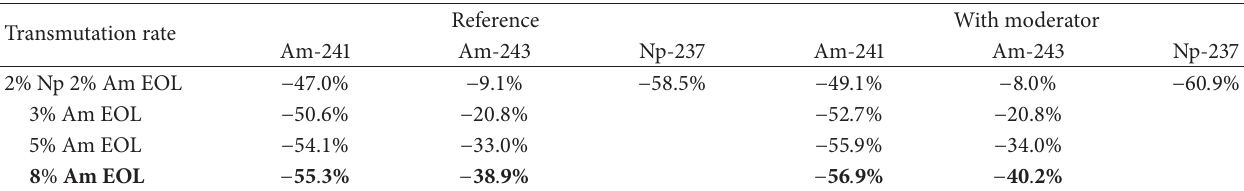
Table 2: Comparison of the transmutation rate for the reference cases and the cases with moderating material for the different transmutation fuels.